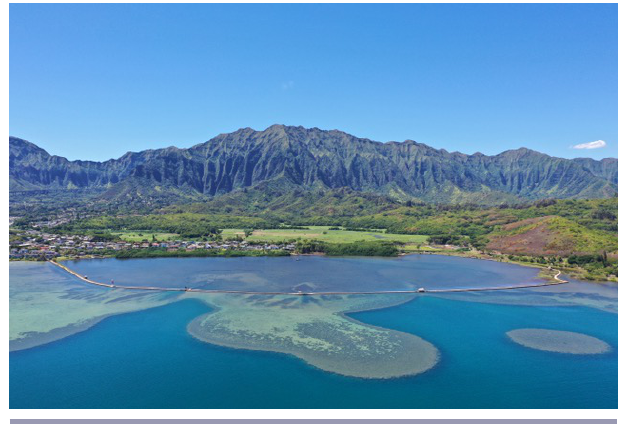
Fig. 3 . An aerial view of He ʻ eia Fishpond, the largest Indigenous aquaculture system in He ʻ eia, which